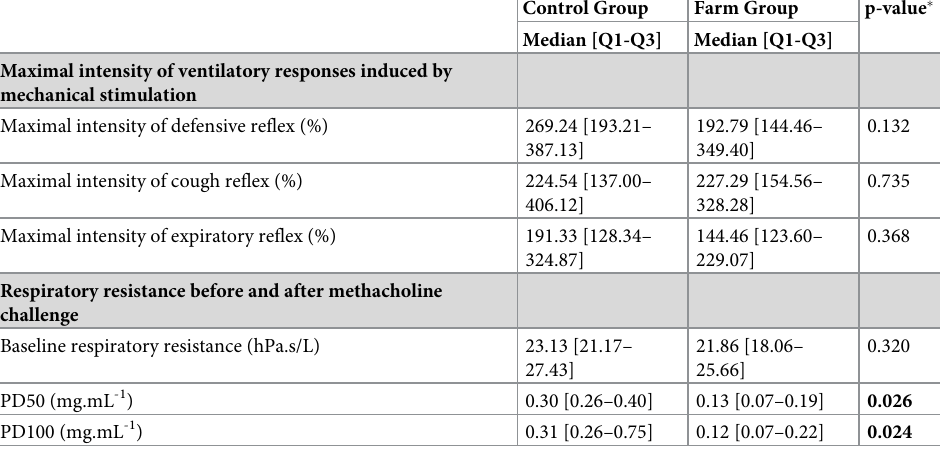
Table 3. Maximal intensity of ventilatory responses induced by mechanical stimulation and respiratory resistance before and after methacholine